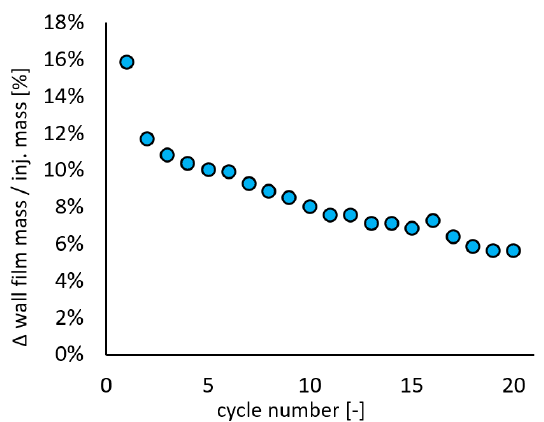
Figure 8. Behavior of the wall film mass during twenty cycles, for the high-pressure case (20 bar): (wall_film_mass cycle i − wall_film_mass cycle i − 1 ) / injected mass per cycle.